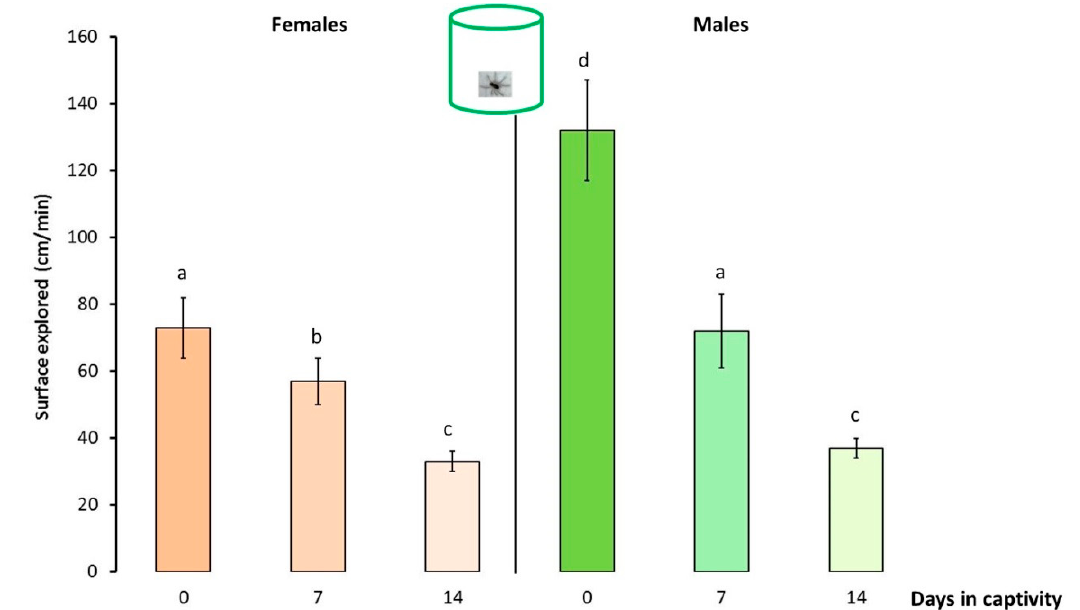
Figure 4. Locomotor activity ±95% confidence intervals (expressed in surface explored, cm/min) of adult female and male Pardosa saltans in terraria after capture in their natural environment (0 day in captivity), seven days after capture (7 days in captivity) and 14 days after capture (14 days in captivity). Data were compared using generalised linear mixed mod (GLMM, negative binomial distribution). Different letters indicate a significant difference ( p < 0.050, post hoc Wald test).